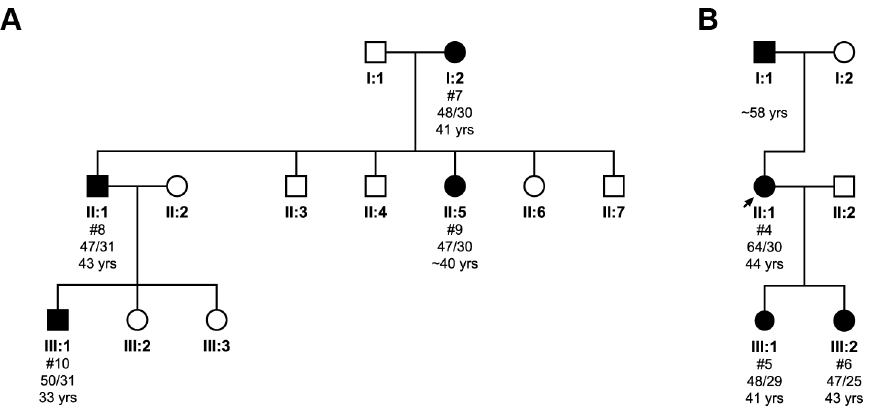
Figure 2. Pedigree analysis and the transmission of the pathogenic expanded allele in two families. Subject numbers ( # ) correspond to cloned individuals indicated in Table S3 , where individual cloned sequences can be found. The mean total repeat size as determined by clone sequencing for each allele is shown, along with the age at disease onset. The first family ( A ) illustrates the transmission of a pure CAG repeat tract across three generations. The second family ( B ) shows transmission of an interrupted pathogenic allele. The limited number of clones analysed may have introduced some degree of sampling error.